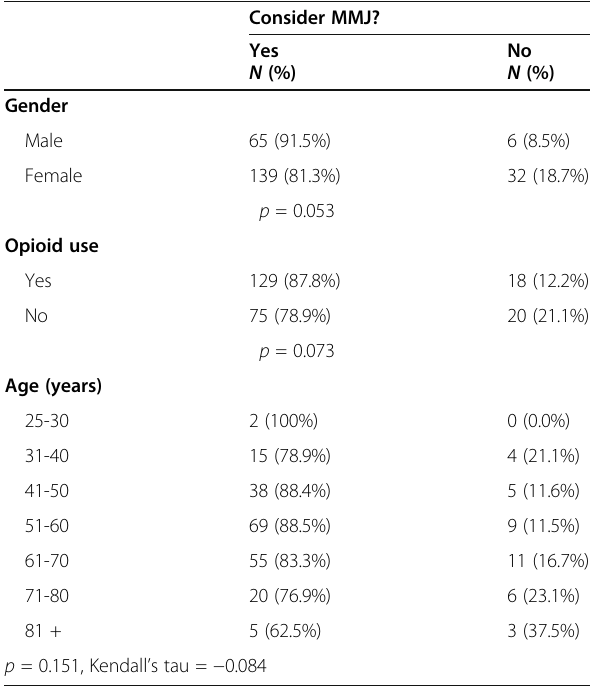
Table 3 Associations with medical marijuana